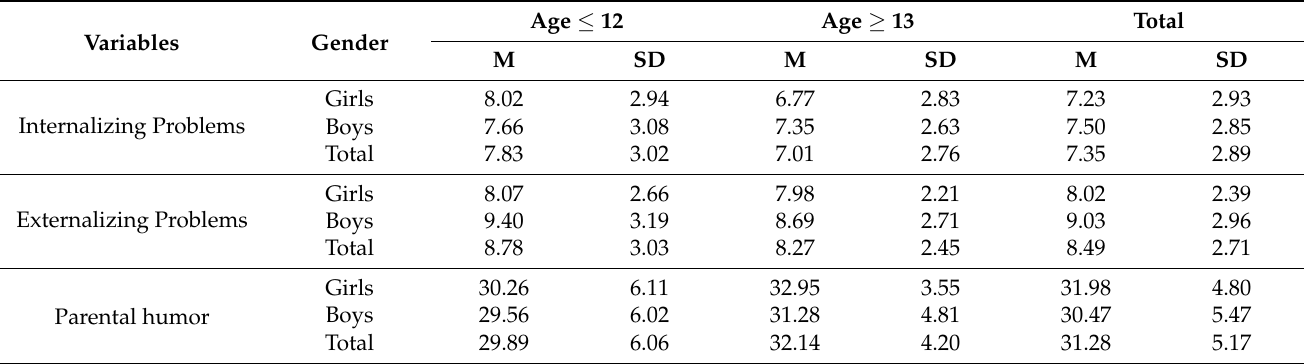
Table 1. Descriptors for the different variables studied. Internalizing Problems, Externalizing Problems, and Parental Humor by age and gender